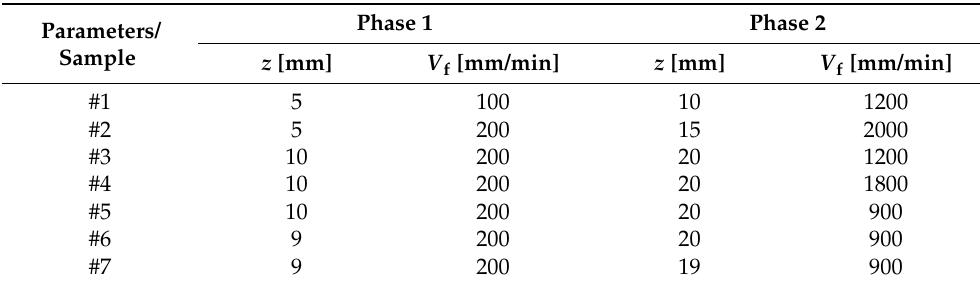
Table 1. Experimental plan for parametric analysis of friction riveting process at constant rivet rotation speed of 19,000 min − 1 .